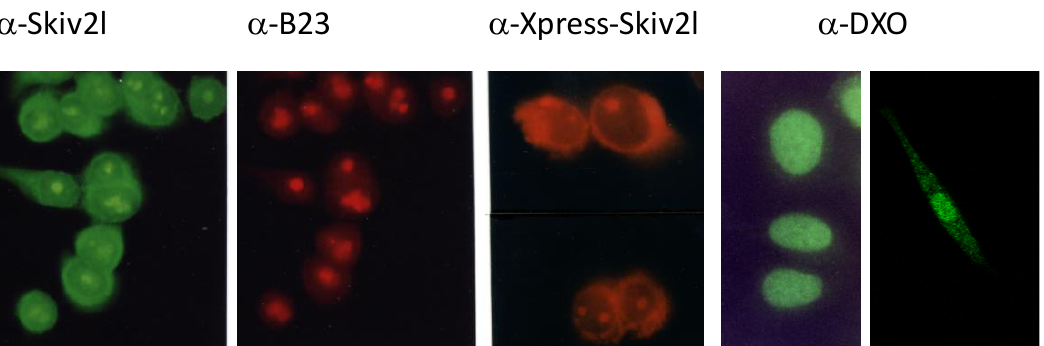
Figure 3. Cellular localization of Skiv2l and DXO in HeLa cells under immunofluorescent microscopy. Human HeLa cells were stained by antibodies against human Skiv2l (Ski2w), nucleoli-specific B23 (nucleophosmin), anti-Xpress for HeLa transfectants with Xpress-Skiv2l fusion protein, and antibodies against DXO (Dom3z). The first three panels illustrate the presence of Skiv2l in the nucleoli and cytoplasm. The fourth and fifth panels show the dominant location of DXO (Dom3z) in the nuclei of HeLa cells. Photographs were originally taken from UV-microscope with 10 × 40 magnifications (modified from [15,52,55]).